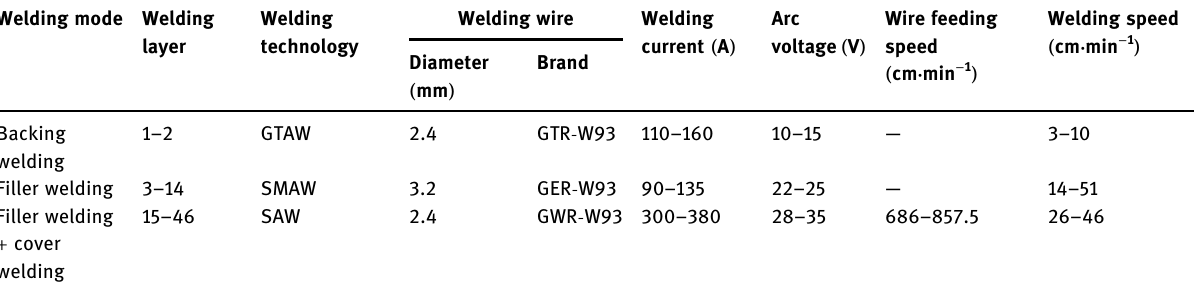
Table 3: Welding